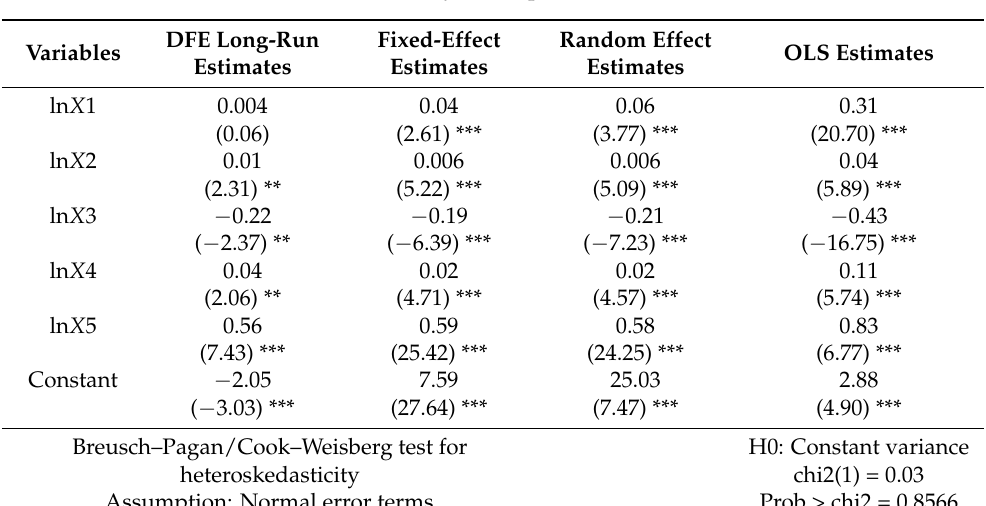
Table 11. Comparison of the results obtained from the dynamic fixed-effect with results obtained from random effect, fixed-effect, and ordinary least square